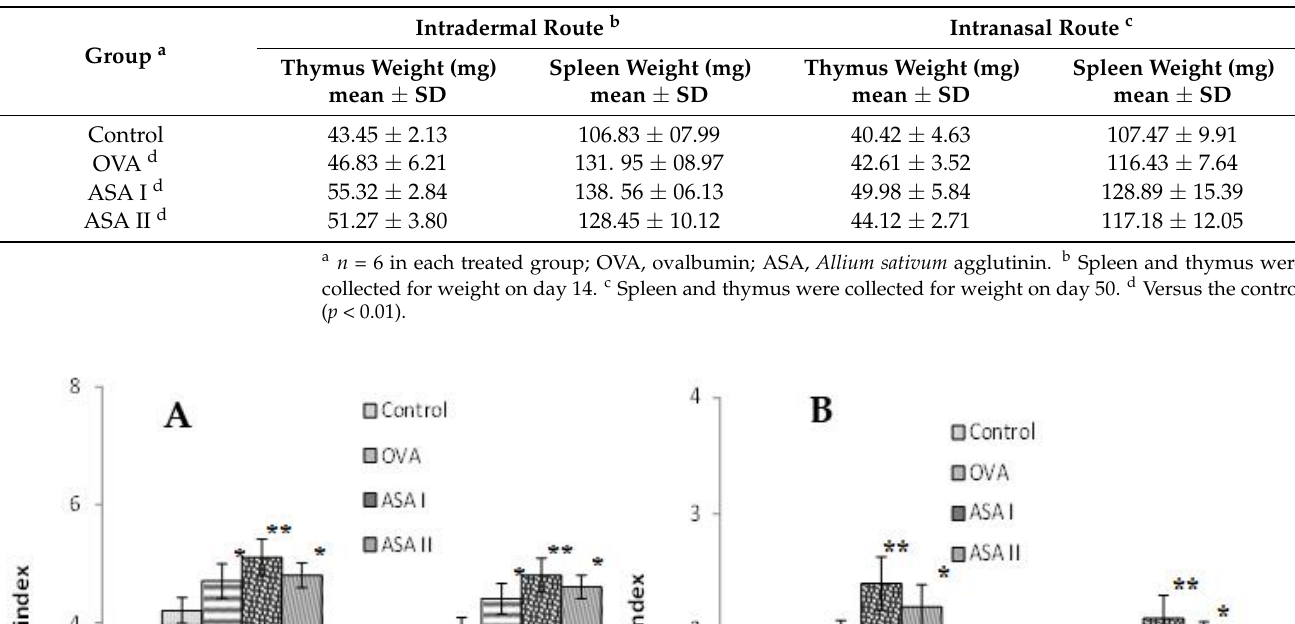
Table 3. Weights of spleen and thymus of BALB/c mice by intradermal (i.d.) and intranasal (i.n.) administration of antigen (OVA, ASA I and II) samples.